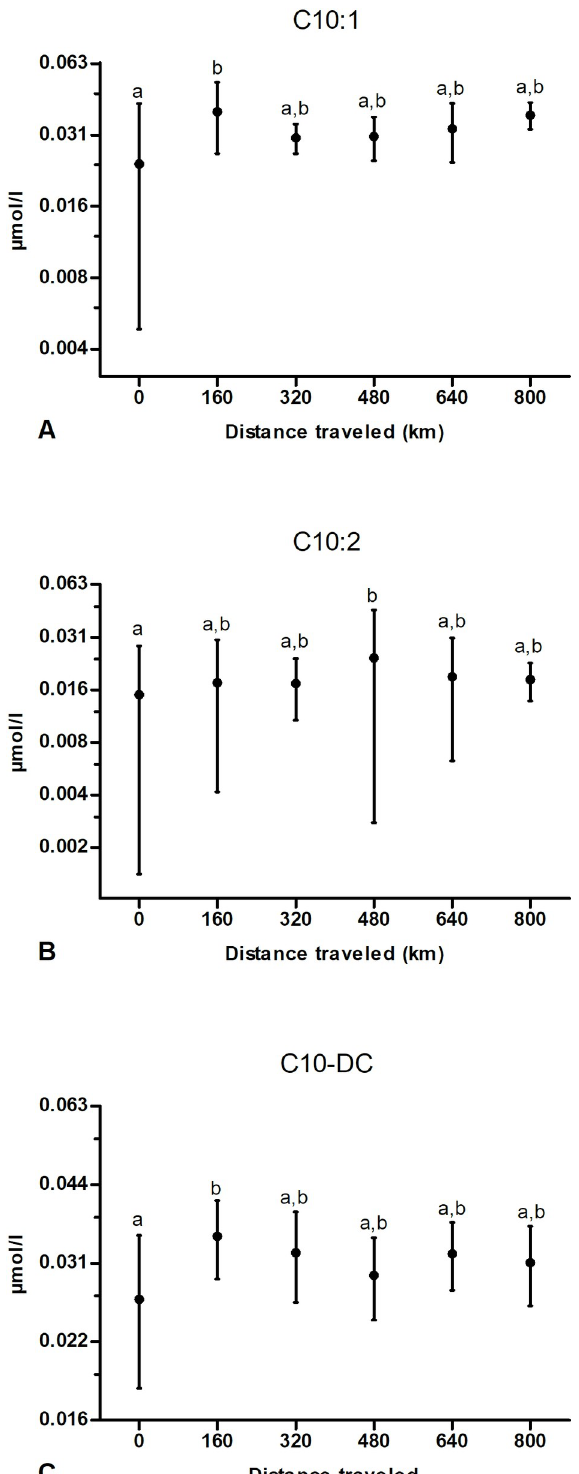
Fig 3. Effect of multiday exercise on some plasma medium-chain acylcarnitines (MCACs). Samples were obtained from 9 dogs at 0, 160, 320, 480, 640 and 800 km. Data are displayed as raw data (mean ± SD) on a logarithmic axis. Columns with different superscripts (a, b) are significantly different between them ( P < 0.05) and not significantly different from columns with the same superscript.